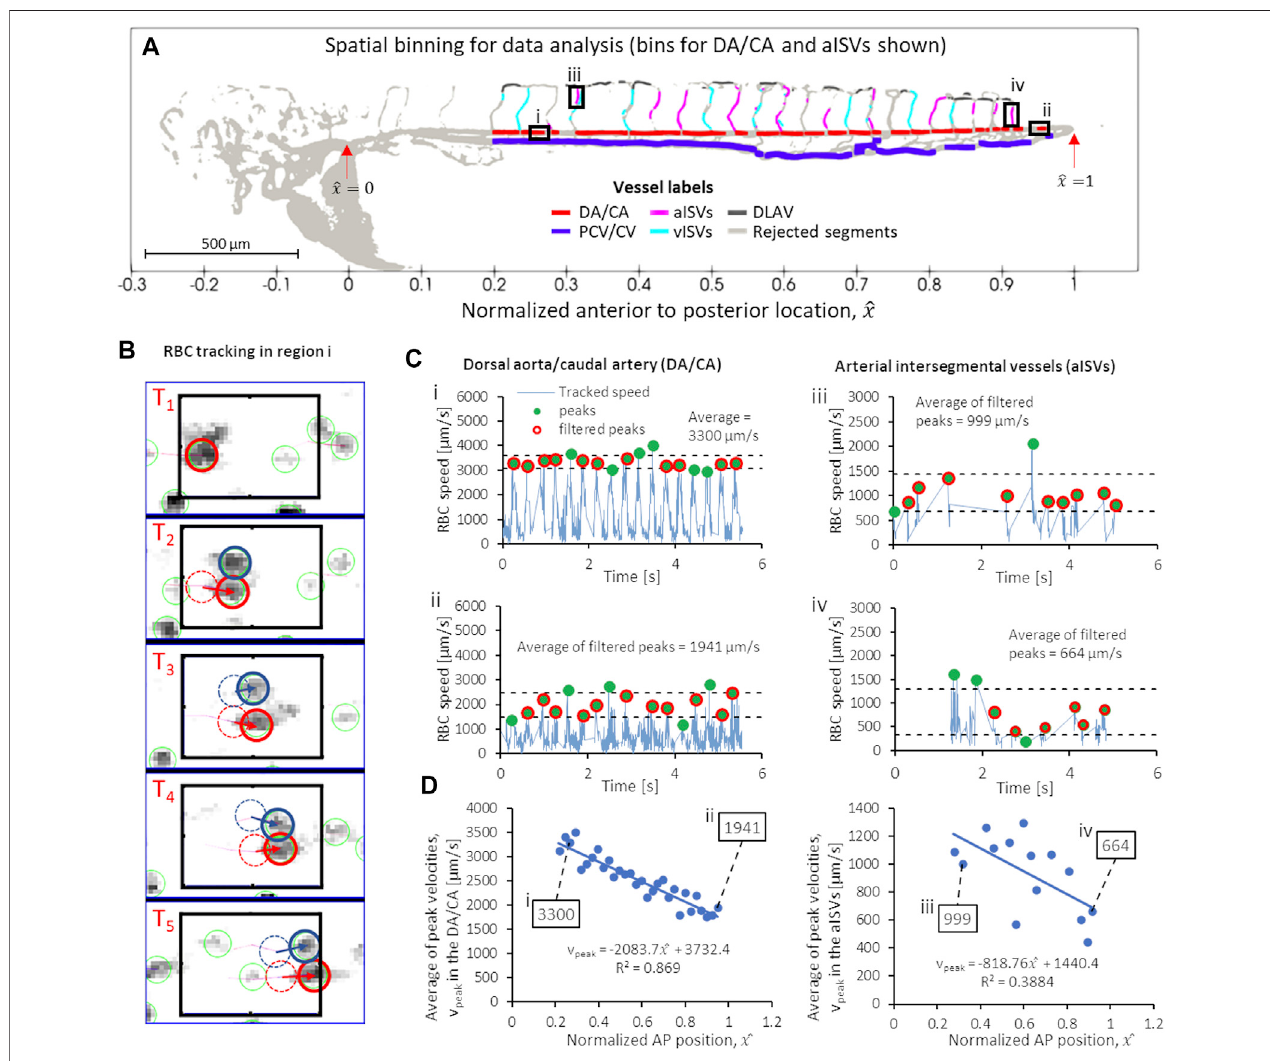
FIGURE 2 | Series of script-automated steps to obtain peak (systolic) RBC velocity from TrackMate data, demonstrated using data from zebra fi sh 28 of the 2 dpf data set. (A) Velocity sampling within spatial bins of controlled intervals in different vessel types: shown in bold line black boxes are the 60-µm intervals for (i) a region in theanteriorDA/CA, (ii) aregionintheposteriorDA/CAandventral-to-dorsalintervalsof fi ltereddata(seetext)foraISVsatthe (iii) anteriorand (iv) posteriorregionsofthe trunk vasculature. (B) Example of TrackMate particle tracking algorithm performed in the anterior DA/CA region (i) shown in (A) . (C) Contiguous velocity against timecurvesandtheapplicationofpeakscanningandoutlier fi lteringtoobtaintheaveragepeak(systolic)velocitiesinregionsi,ii,iiiandivshownin (A) . (D) Theanterior-to- posterior distribution of average peak velocities in the DA/CA (left) and aISVs (right) with the values for the four locations (i – iv) highlighted in (A,C) shown in boxes.